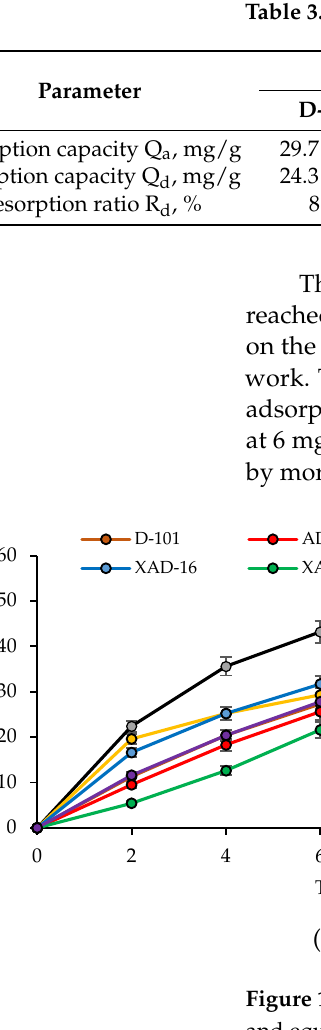
Table 4. Desorption ratio of total cucumber fl ower fl avonoids on Amberlite XAD-2 after elution with alcohol-water mixtures.